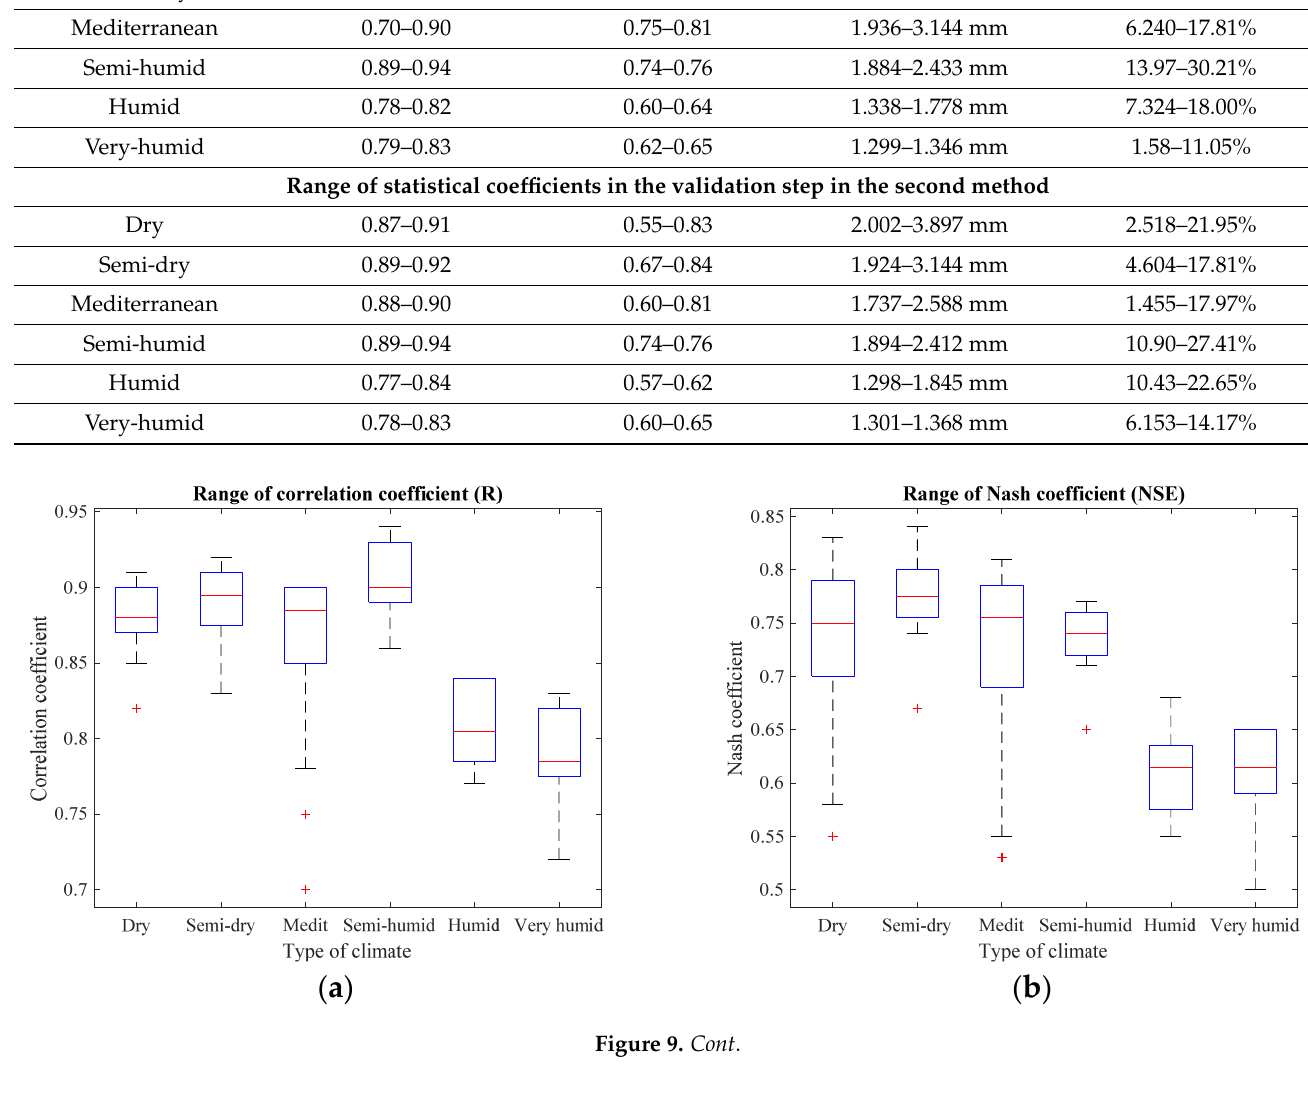
( d ) Figure 9. Box plots of statistical coefficients obtained in validation of the two novel methods using data from 32 synoptic weather stations in Iran. Table 4. Range of values of statistical indicators obtained in validation of the two novel methods with the two-parameter input combination using data from 32 synoptic weather stations in Iran. Percentage bias (PBIAS) Root mean squared error (RMSE) Nash-Sutcliffe coefficient (NSE) Correlation coefficient (r) Climate